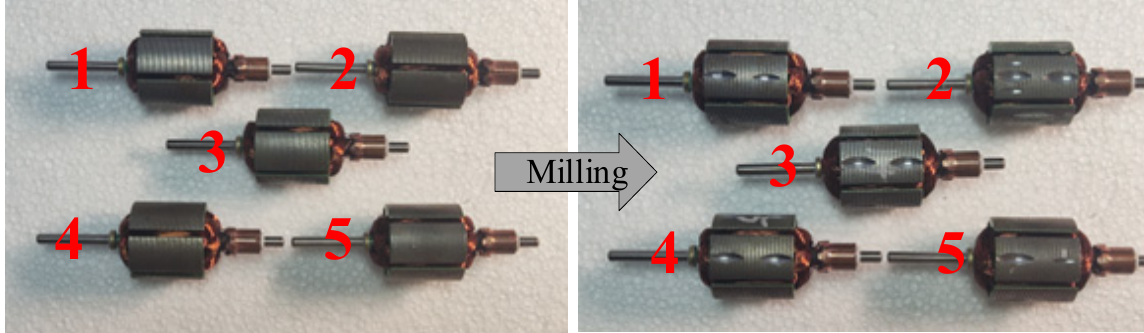
Figure 11. Experimental rotors after milling with the method of discrete model.